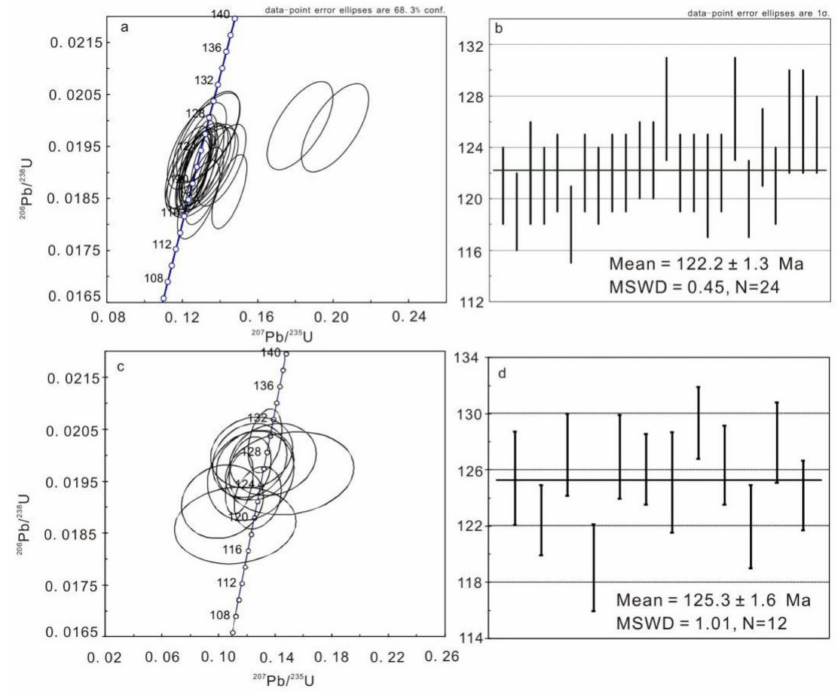
Figure 6. LA–ICP–MS and SHRIMP zircon U–Pb concordia and weighted mean age diagrams of the Sanguliu granodiorite ( a , b ) and monzodioritic enclave ( c , d ). Similarly, thirteen zircons’ analyses from the monzodioritic enclaves resulted in a tight cluster on a concordia (Figure 6c) and their 206 Pb/ 238 U ages range from 119.1 ± 3.1 to 129.4 ± 2.6 Ma, with a weighted mean age of 125.3 ± 1.6 Ma (MSWD = 1.01, N =